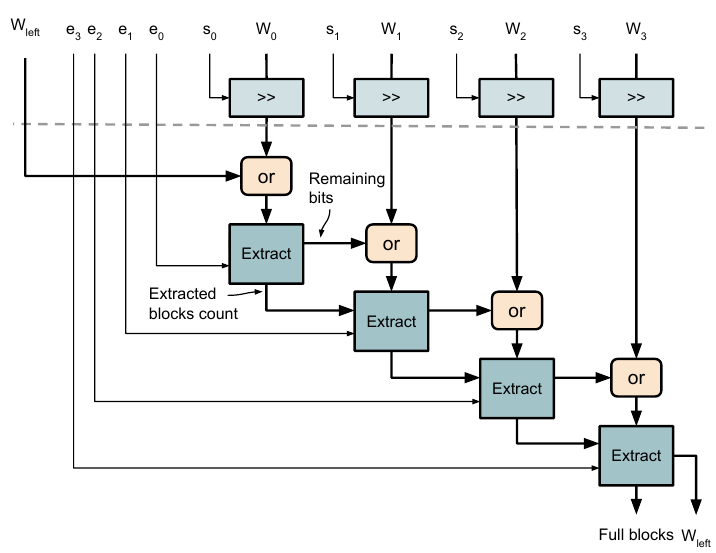
Figure 10. Implementation of variable length word packer.